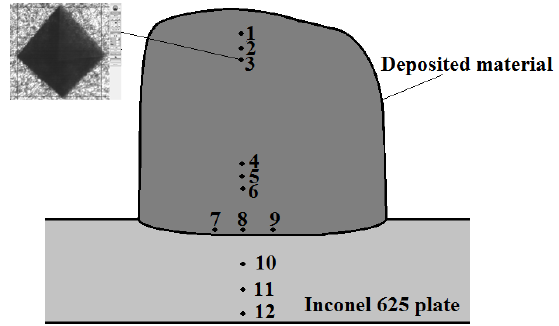
Figure 6: Point distribution of measured hardness test in laser manufactured specimen